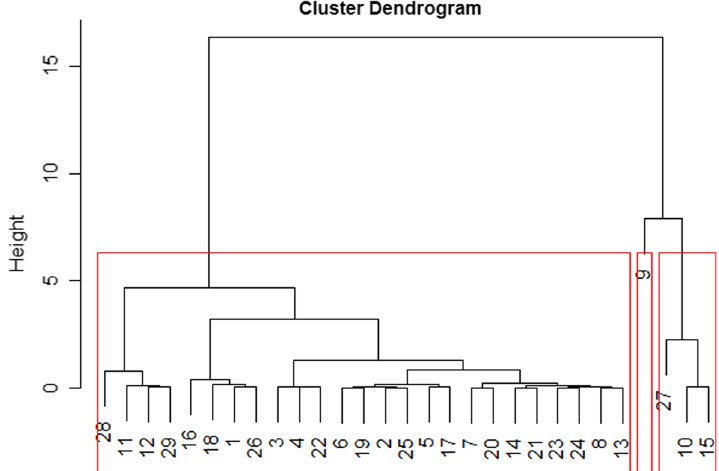
Fig. 17 Cluster dendrogram with spatial correlations in Stage 4. Note The numbers 1, 3, 12, 14, 16, and 23, 26 denote stock indices in developed markets; the remaining numbers denote indices in developing